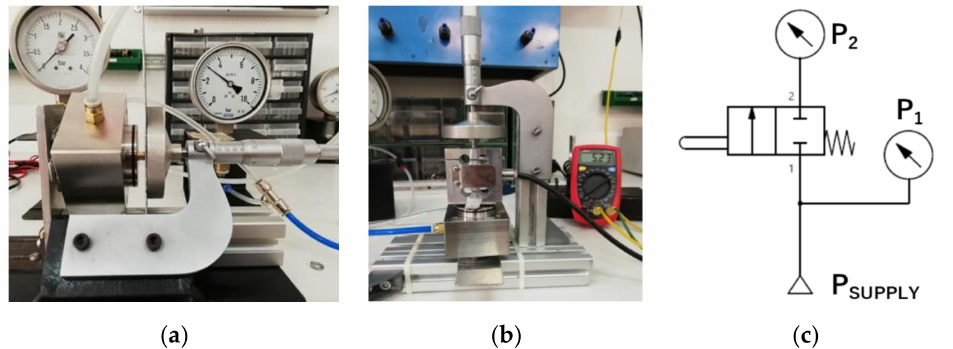
Figure 10. Experimental testbeds: ( a ) for the achievement of the minimum stroke of the plunger; ( b ) for the achievement of the switching force; ( c ) the adopted pneumatic